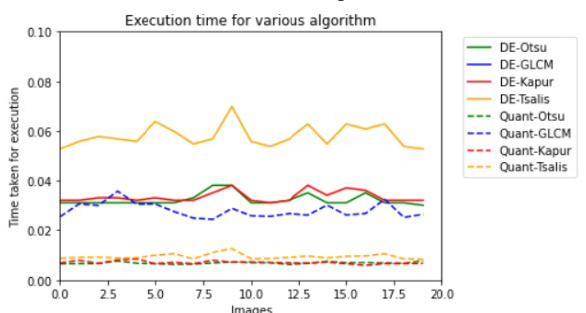
Figure 3: Comparing of thresholds of various algorithm for 20 different images